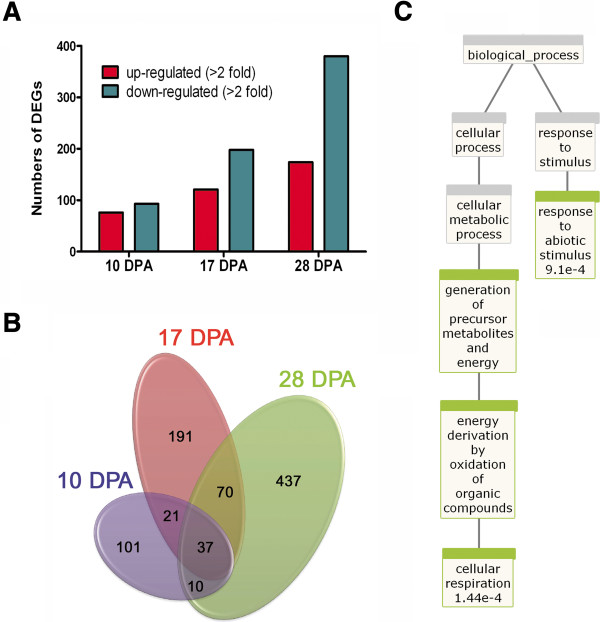
Summary of microarray analysis comparing TM-1 wild type and im mutant. A. Comparison of up- or down-regulated DEGs at 10, 17, and 28 DPA in the im mutant fibers. B. Venn diagrams representing the common DEGs among the three developmental stages in the im mutant. C. BioMaps enrichment analysis from the common DEGs at 10, 17, and 28 DPA in the im mutant fibers. Genes involved in abiotic stimulus response (p = 0.009) and cellular respiration (p = 0.000144) were enriched in the im mutant fibers.